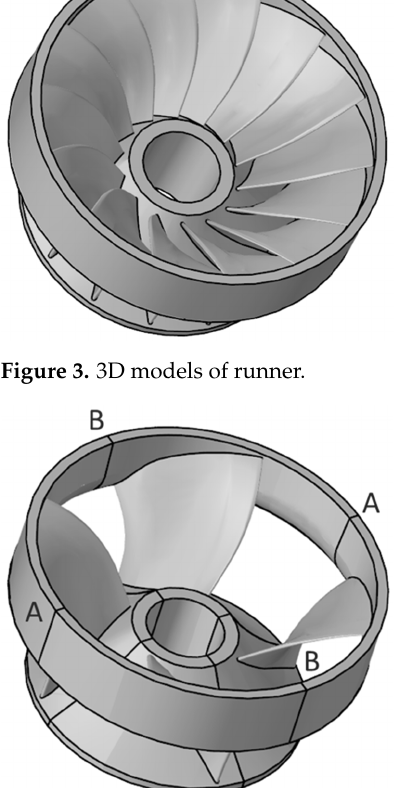
Figure 4. 3D models of simplified runner.